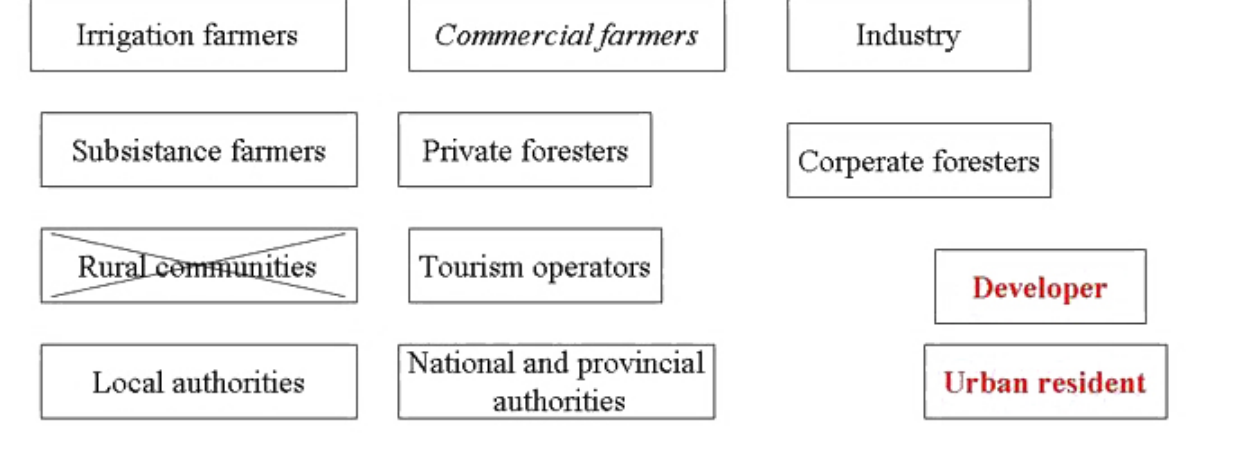
Fig. 2 . ARDI stage 1 at Crocodile River: “What are the main stakeholders that seem to be able to or need to play a decisive role in managing the river flow?” Words or concepts written in red were added during the later steps of the ARDI. Words or concepts written in italics were proposed by the facilitator to get out of a deadlock. A crossed box means that the idea was finally